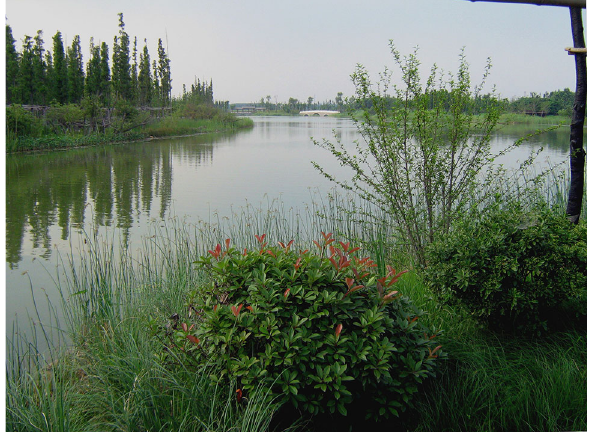
Fig. 4 Pan’an Wetland Park in Xuzhou/China, created through the restoration of post-mining areas (photo: